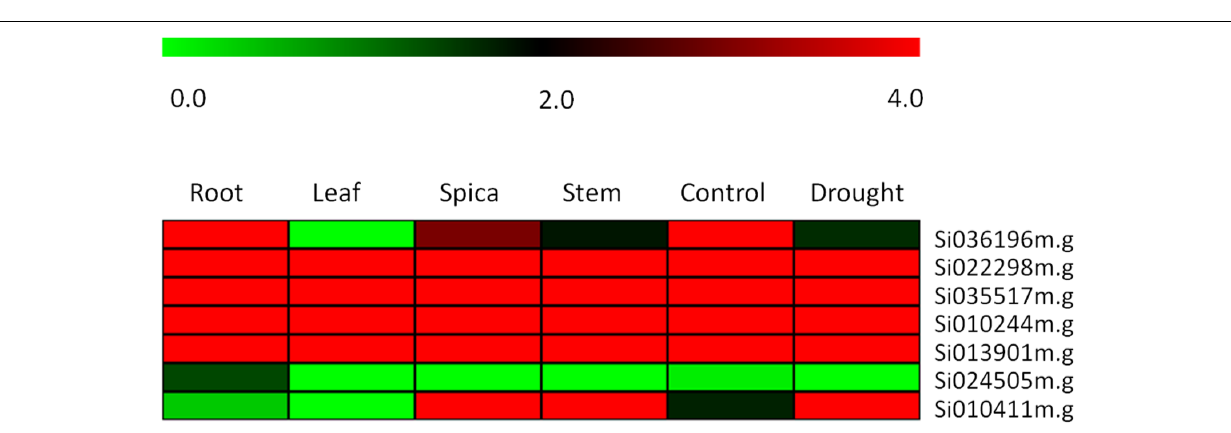
FIGURE 5 | Heatmap showing the expression pattern of SiZIP genes in four tissues, namely root, leaf, spica and stem along with control and drought stress library of Setaria italica . The colored bar at top left represents relative expression value, where 0.0, 2.0, and 4.0 denotes low, medium, and high expression,